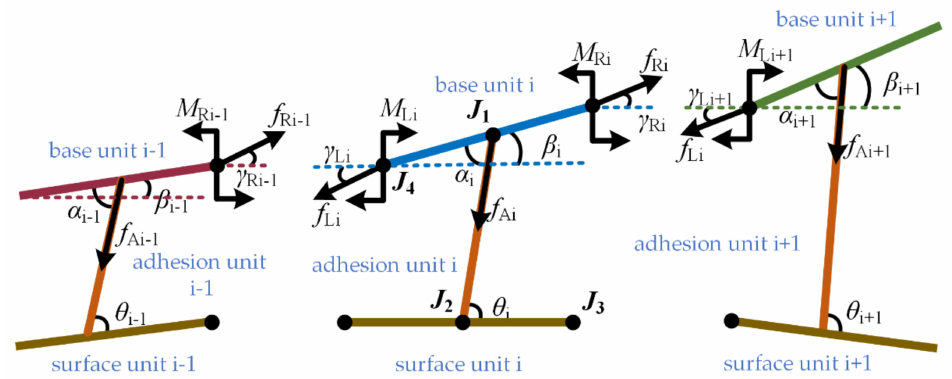
Figure 3. Micro adhesion model of adhesion